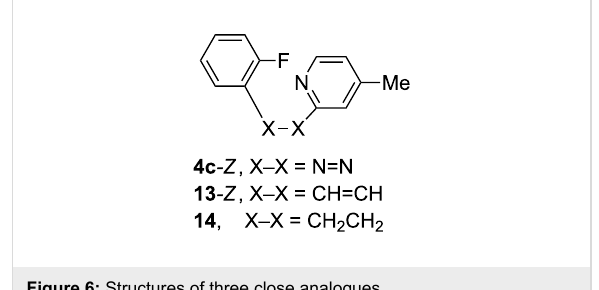
Figure 6: Structures of three close